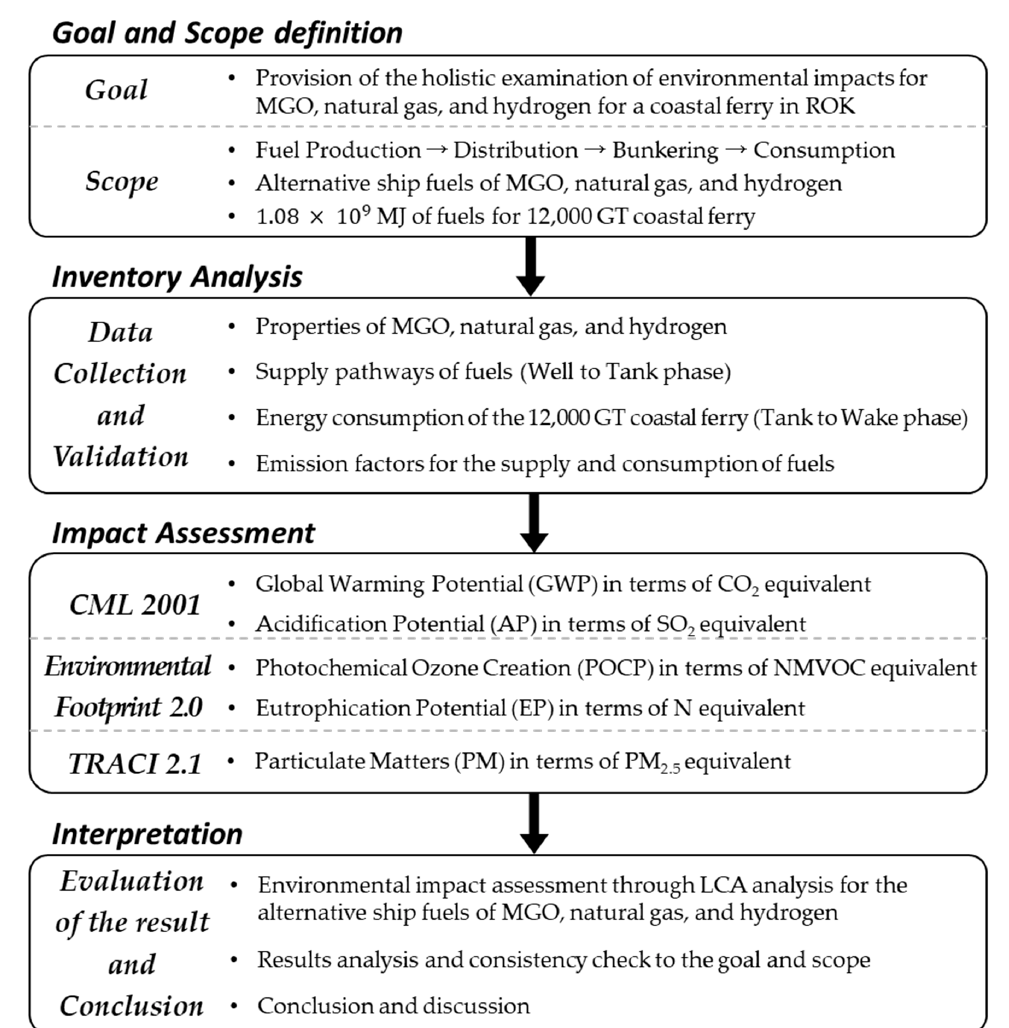
Figure 1. Life cycle assessment framework for various alternative fuels for ships.